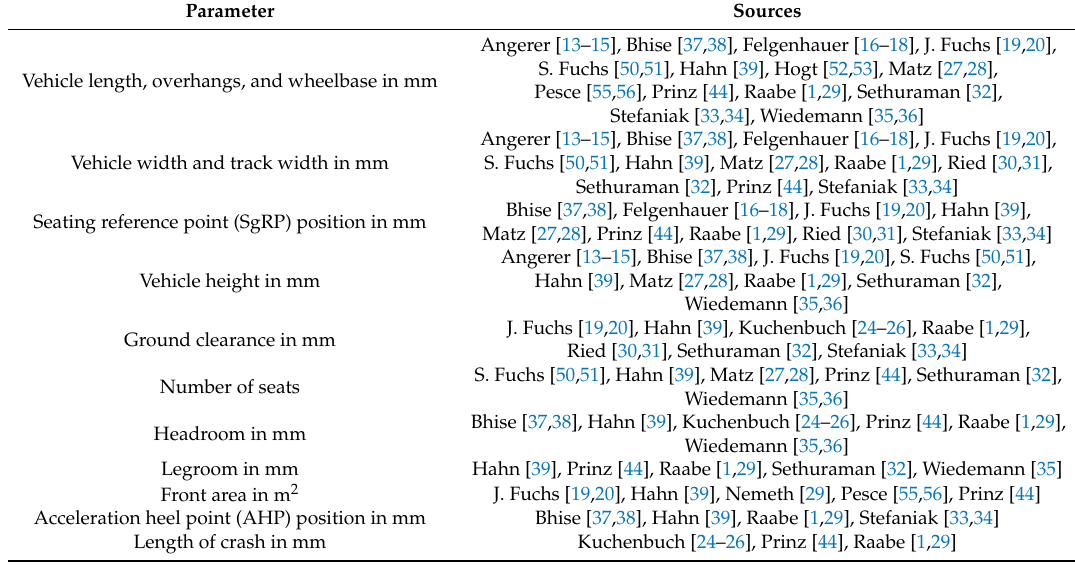
Table 2. Overview of the design parameters for the dimensional